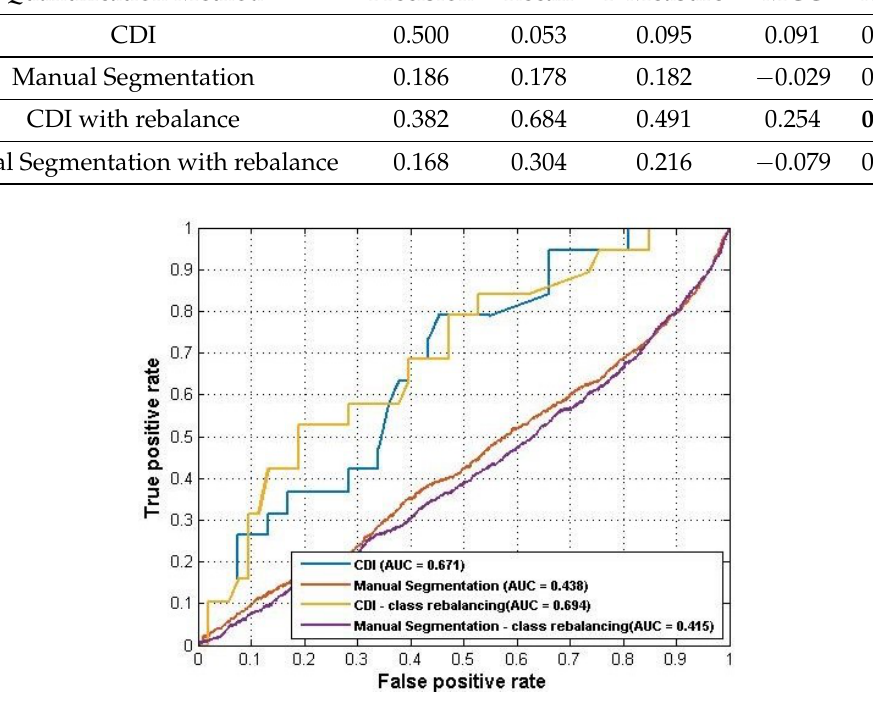
Figure 5. ROC plot of top CDI (#7, #8, and #9) and manual segmentation on X3 slice.